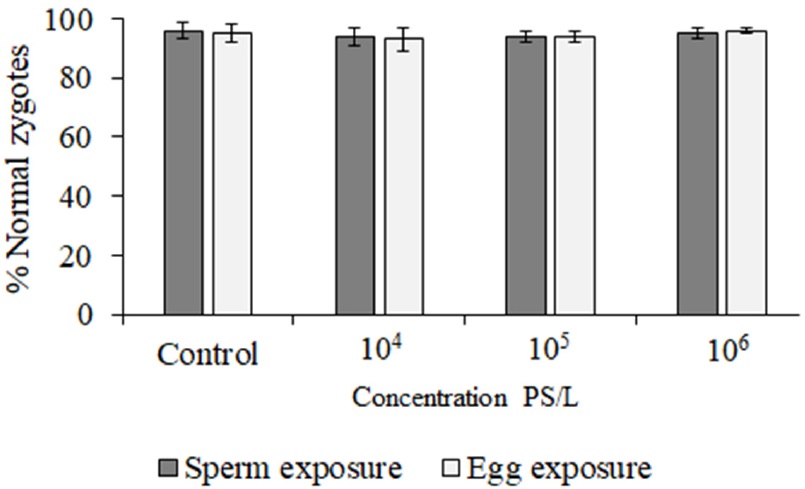
Figure 3. Effect of polystyrene microspheres on fertilisation success when exposed to S. mirabilis gametes (mean ± standard deviation, N = 16; n = 1600).